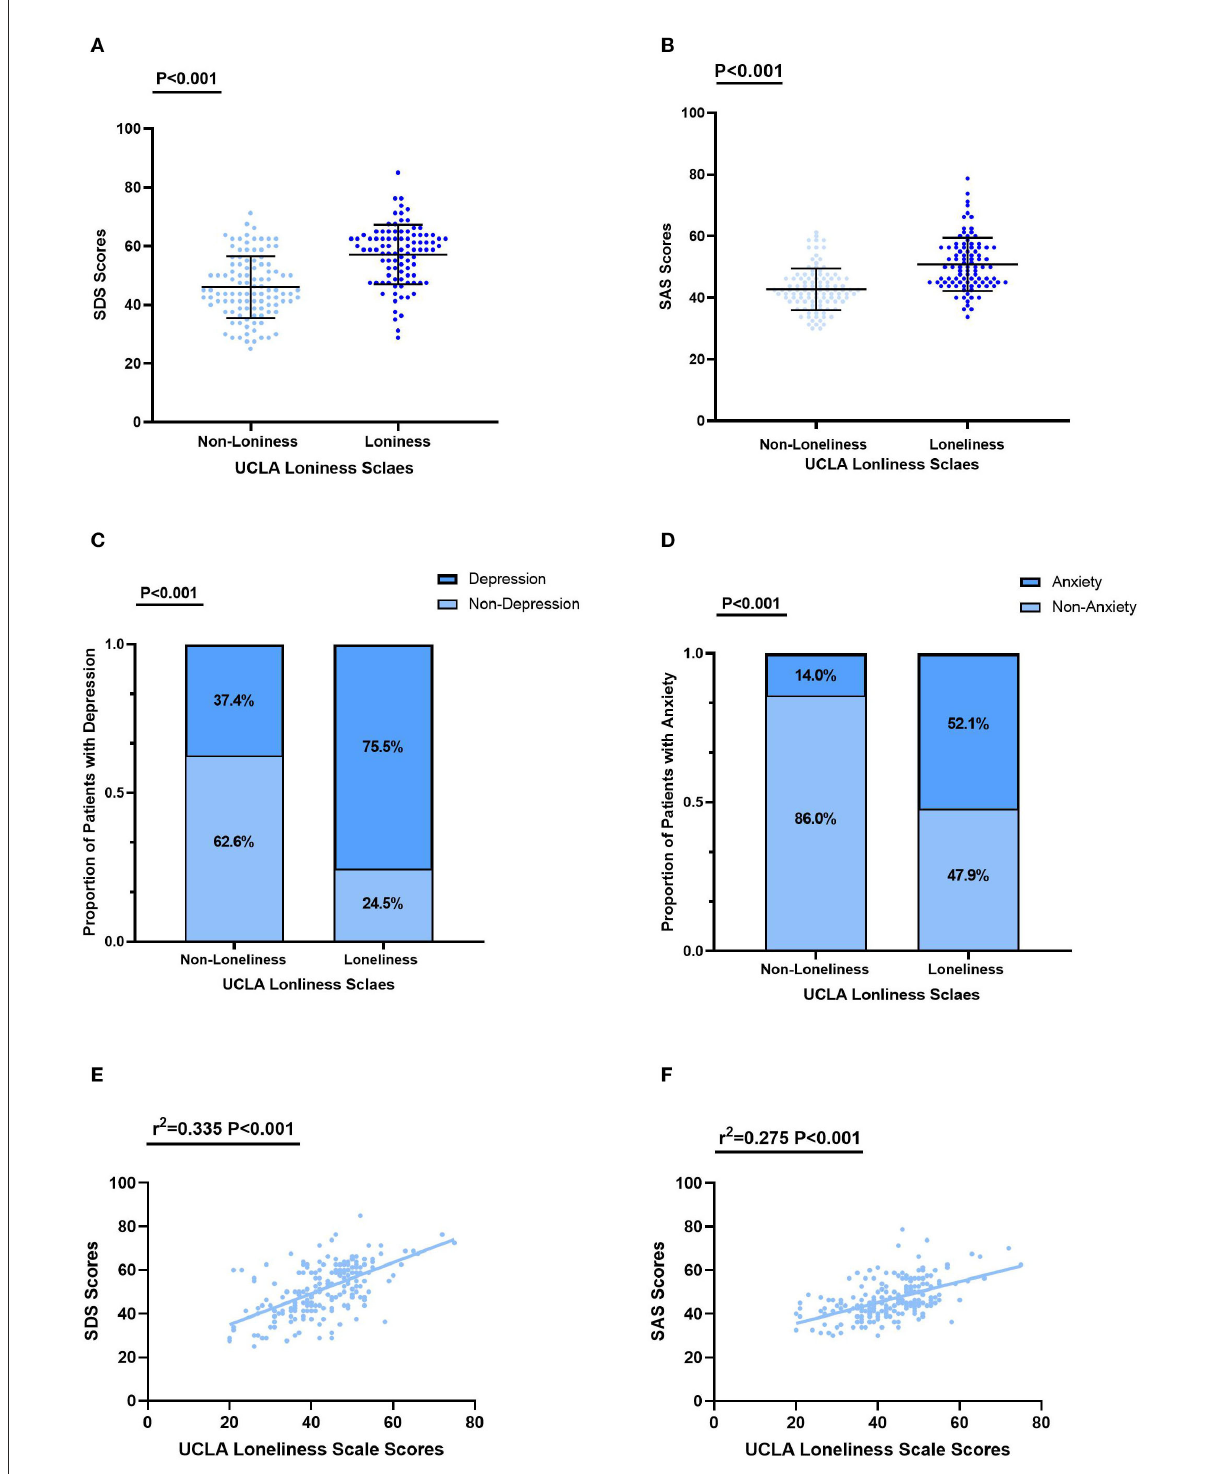
FIGURE1 Levels of depression and anxiety in the loneliness and non–loneliness groups. (A) The depression score of PLWHIV with loneliness were 57.10 ± 10.12, significantly higher than in that without loneliness 46.02 ± 10.50 ( P < 0.001). (B) The depression score of PLWHIV with loneliness were 52.85 ± 8.61, significantly higher than in that without loneliness 42.75 ± 6.79 ( P < 0.001). (C) The proportion of diagnosed with depression was